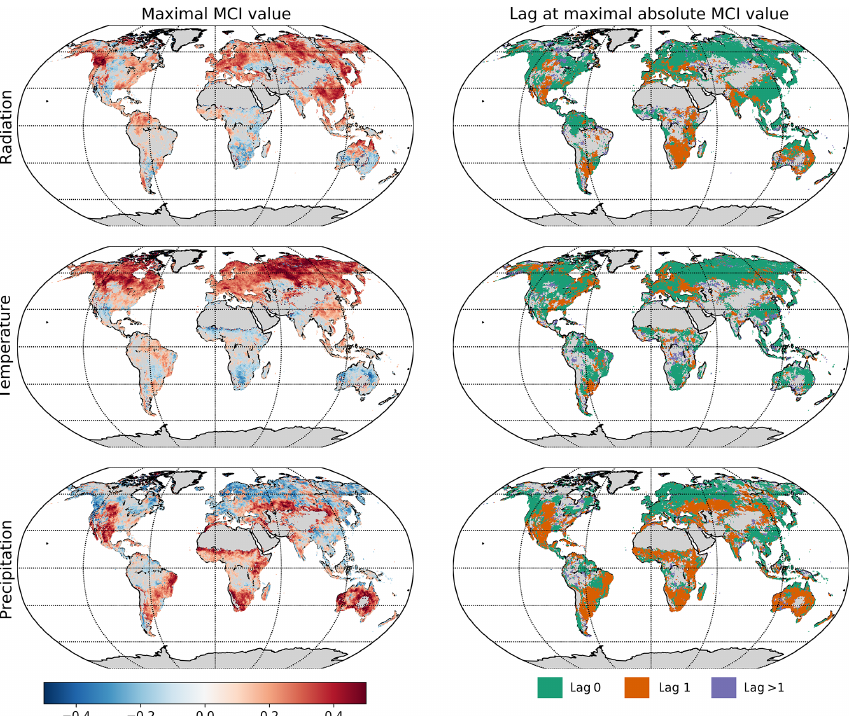
Figure 6. Influence of climatic drivers on NDVI as calculated by PCMCI. The first column shows the estimated causal influence given as maximal absolute MCI value of climatic drivers on NDVI. The second column gives the time lag at which the maximal absolute MCI value occurs (in months).